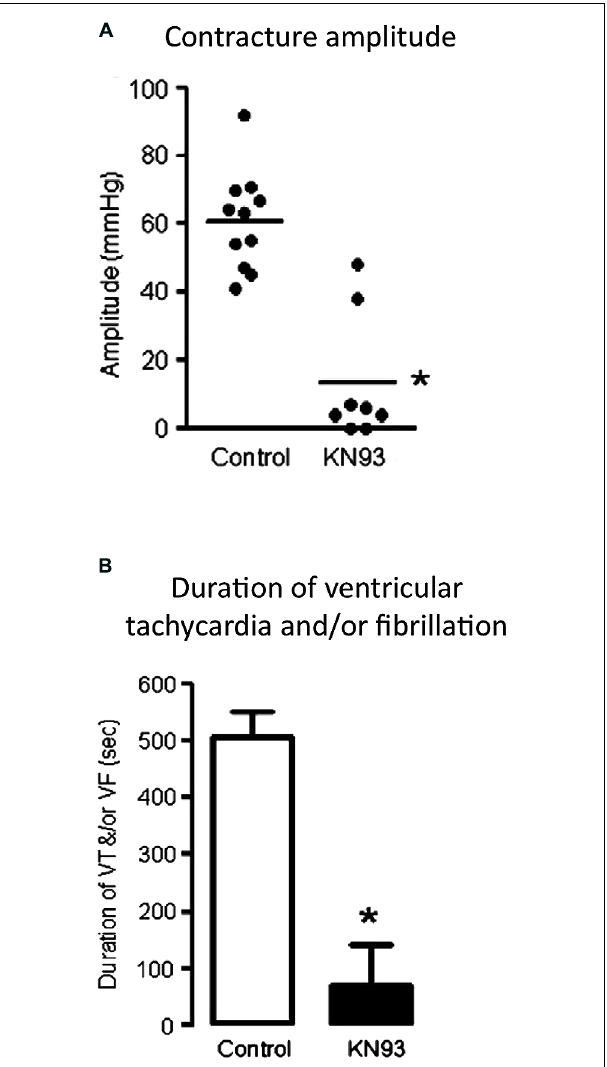
FIGURE 2 | CaMKII inhibition reduces ischemic contracture and reperfusion arrhythmias in male ex vivo hearts. Hearts subjected to ischemia/reperfusion were treated with a CaMKII inhibitor (KN93). (A) The amplitude of ischemic contracture was significantly lower in the presence of KN93, indicating CaMKII contributes to cardiomyocyte Ca 2 + loading in ischemia. (B) Analysis of ventricular pressure traces showed a substantial reduction in the total duration of ventricular tachycardia and/or fibrillation in the first ten minutes of reperfusion in KN93-treated hearts. Data are expressed as mean ± SEM, * p < 0.05 vs. control. Reproduced with permission (Elsevier, (Bell etal.,